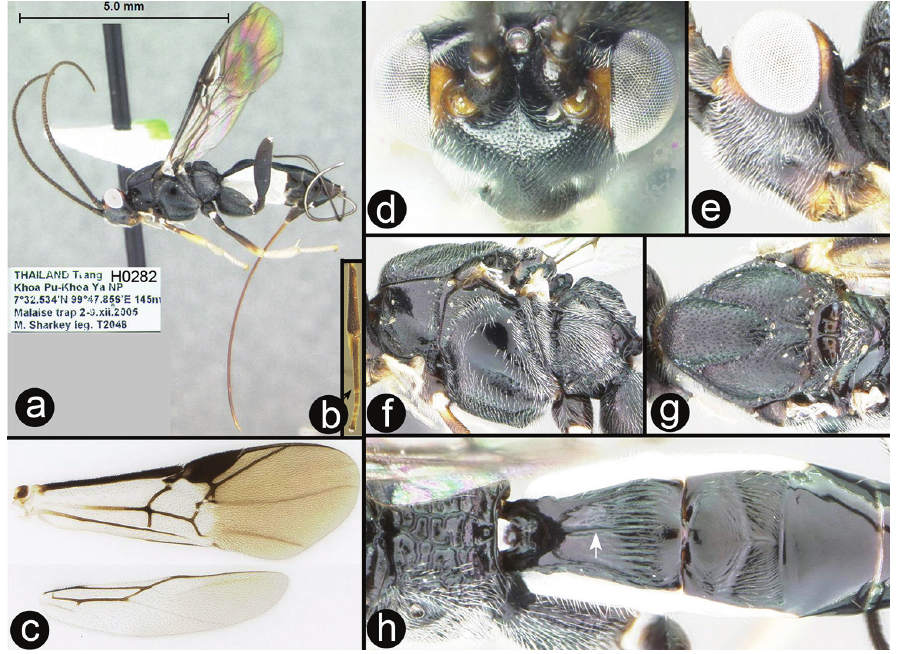
Figure 11. Liragathis baonai paratype female: a lateral habitus b hind tibia and tarsus c wings d dorsal